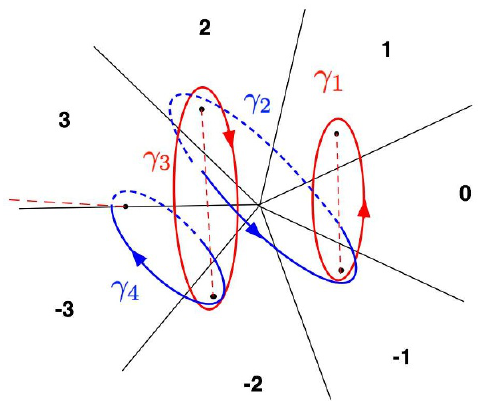
Figure 1 . The integration contours γ s for the Y-functions for the A 4 case. The contour is defined on the Riemann surface ξ 2 = x 5 + v . The numbers stand for the number of sectors. The black dots stand for the zeros of x 5 + v . The red dot lines are the branch